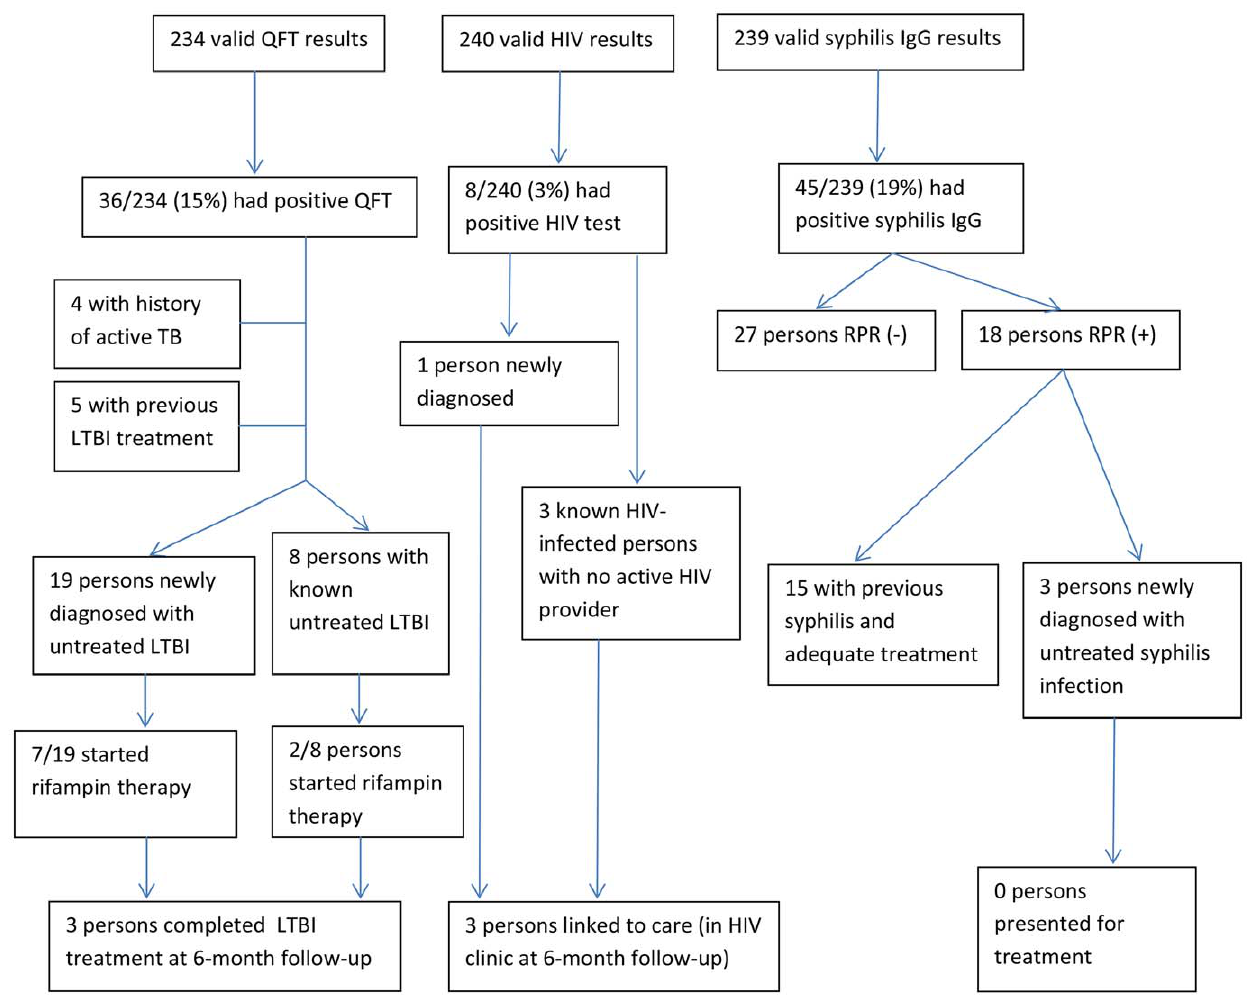
Figure 3. Yield and Follow-up from Geographic-based Screening for HIV, TB, and Syphilis. After six months of follow-up, three persons completed LTBI treatment, three persons with HIV were linked to care, and no patients presented for syphilis therapy